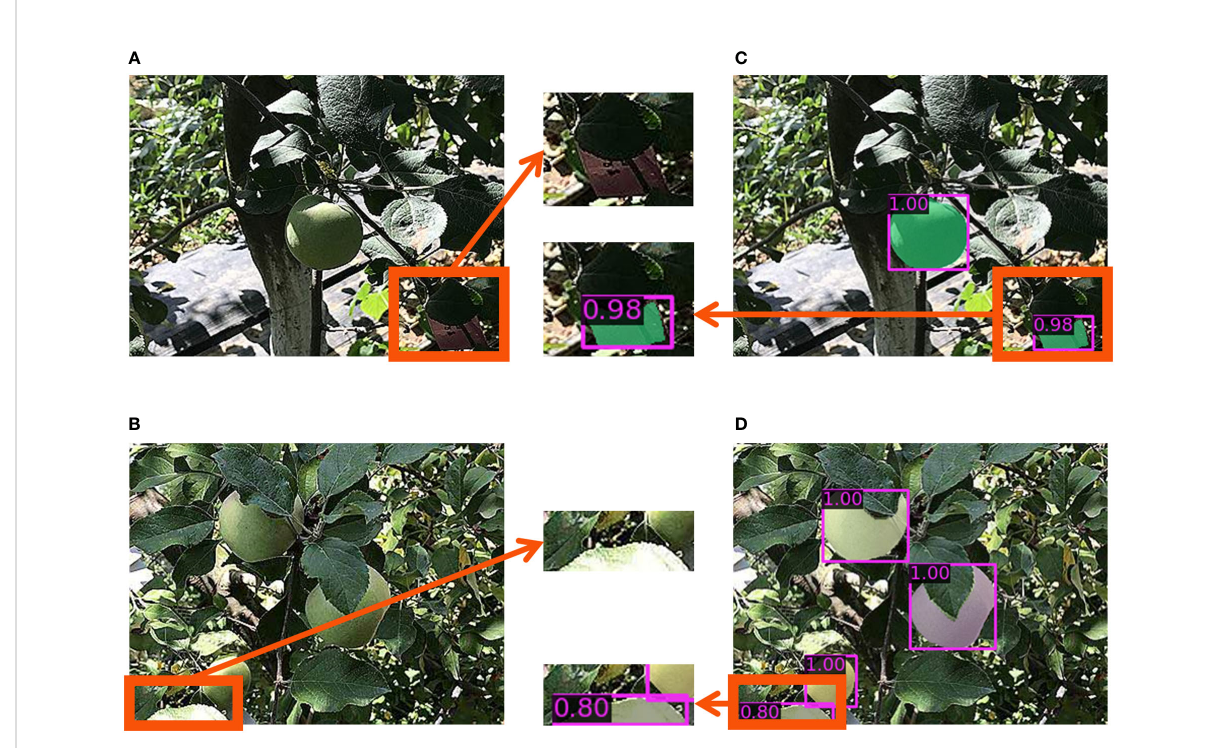
FIGURE 5 False detection and segmentation. (A, B) Original images. (C, D) Detection and instance segmentation results of original images (A, B)